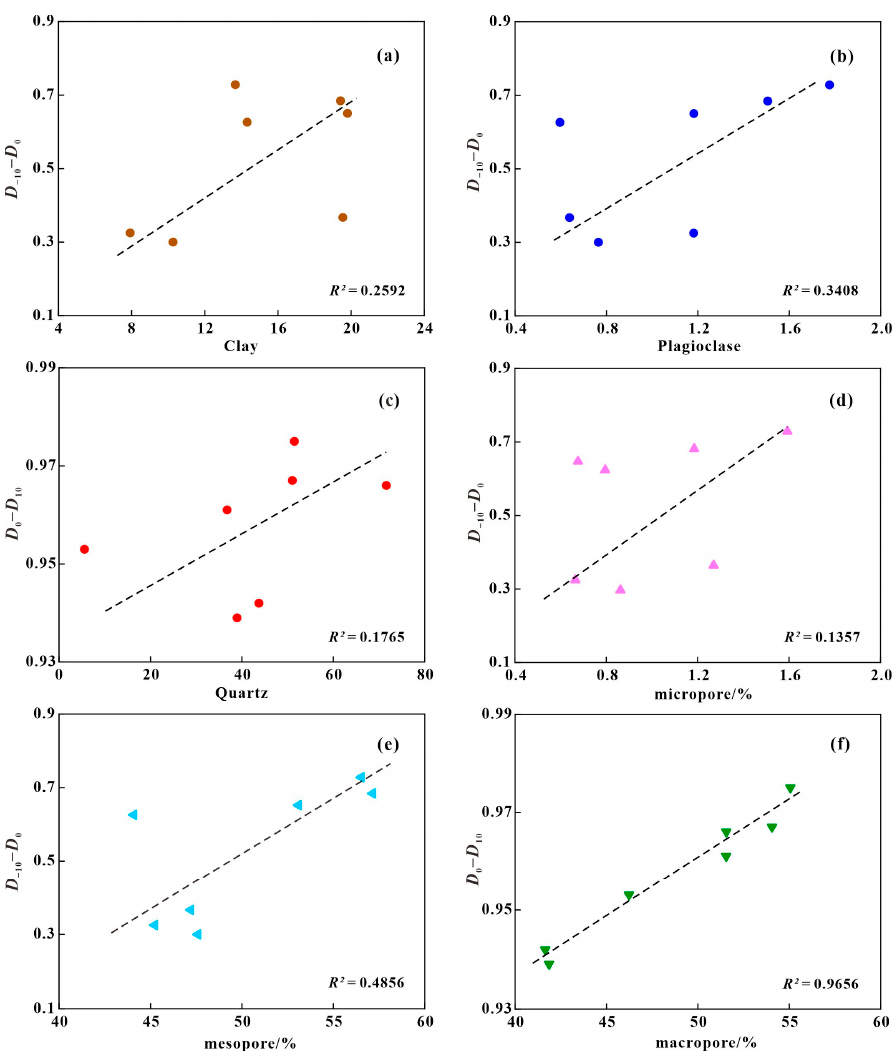
Figure 11. Influencing factors of multi-fractal dimension: ( a ) Relationship between D − 10 − D 0 and clay content. ( b ) Relationship between D − 10 − D 0 and plagioclase content. ( c ) Relationship between D 0 − D 10 and quartz content. ( d ) Relationship between D − 10 − D 0 and micropore volume. ( e ) Relationship between D − 10 − D 0 and mesopore volume. ( f ) Relationship between D 0 − D 10 and macropore volume.